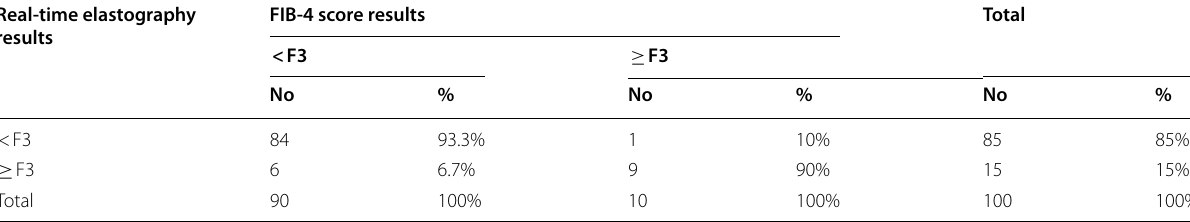
Table 6 Degree of agreement between real-time elastography results and FIB-4 score results